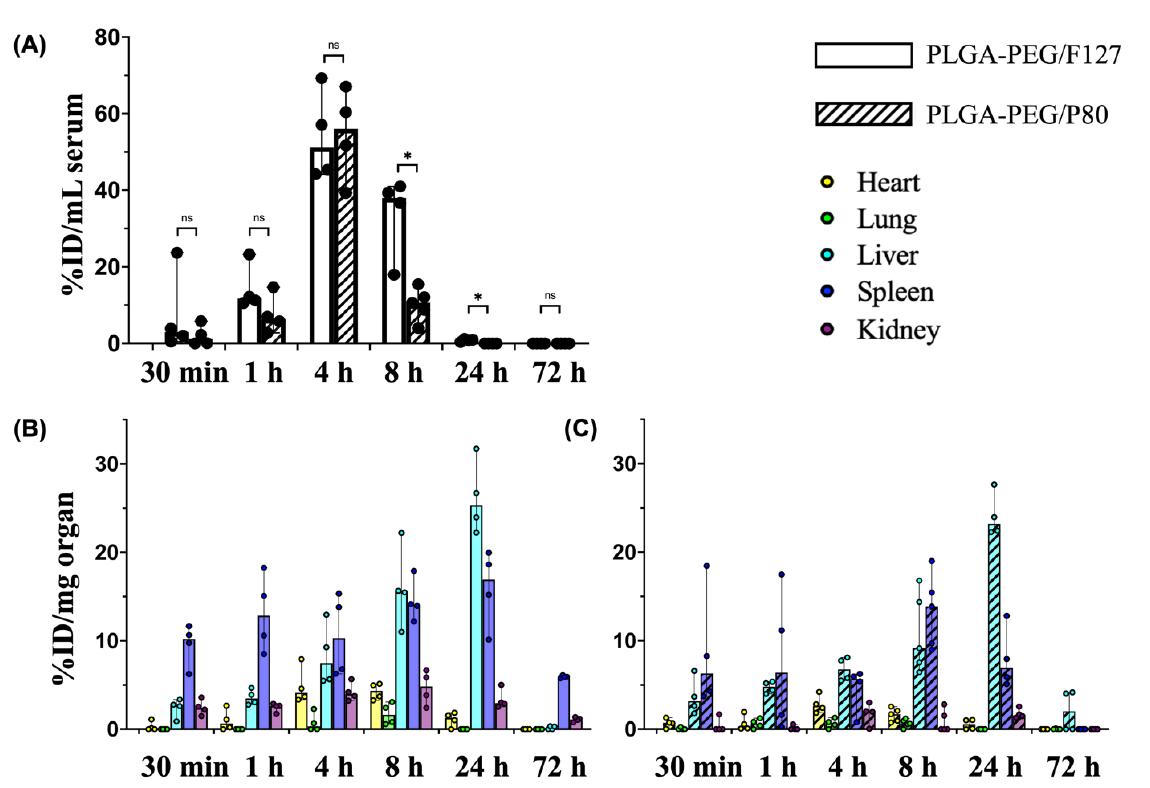
Figure 3. Biodistribution of PLGA-PEG/F127 and PLGA-PEG/P80 versus post-injection time (30 min,